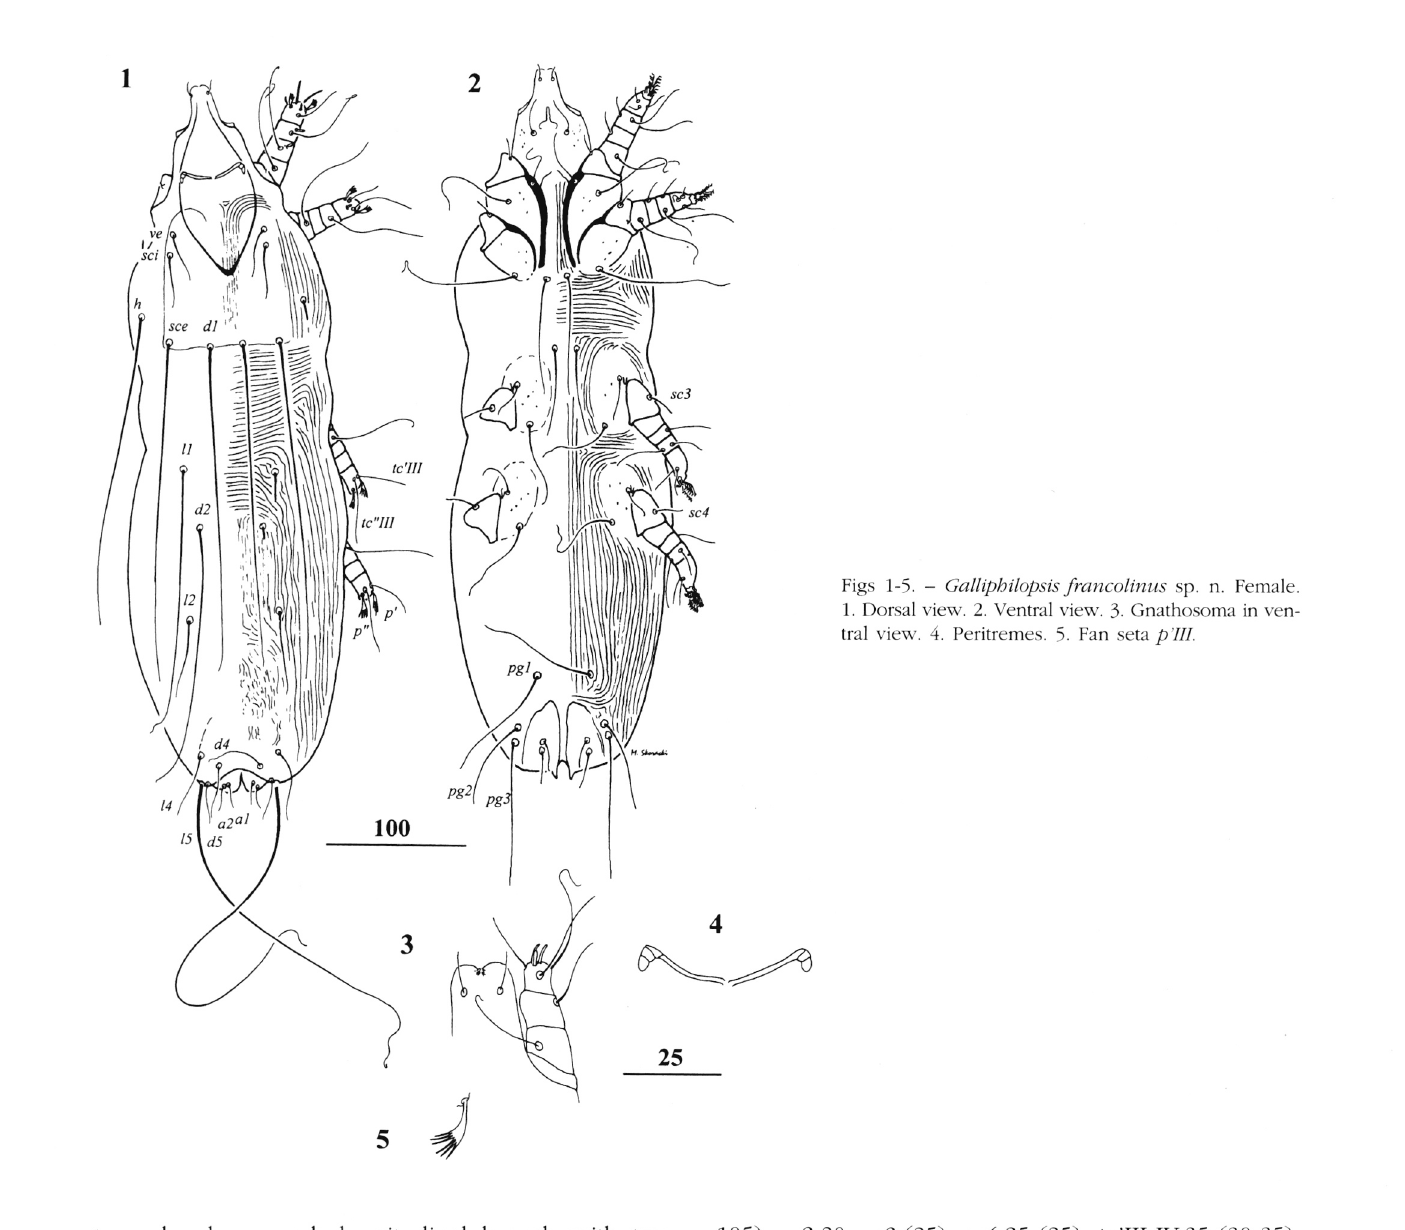
Figs 1-5. - Galliphilopsis francolinus sp. n. Female. 1. Dorsal view. 2. Ventral view. 3. Gnathosoma in ven­ tral view. 4. Peritremes. 5. Fan seta